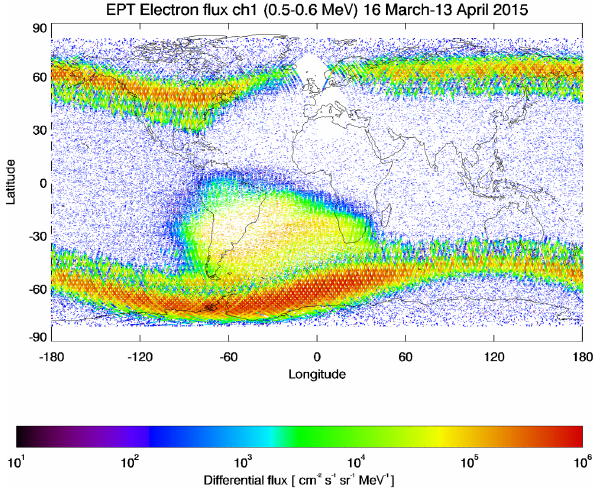
Figure 10. Map of the electron fluxes observed by EPT/PROBA-V in Channel 1 between 16 March and 13 April 2015 (after the event).